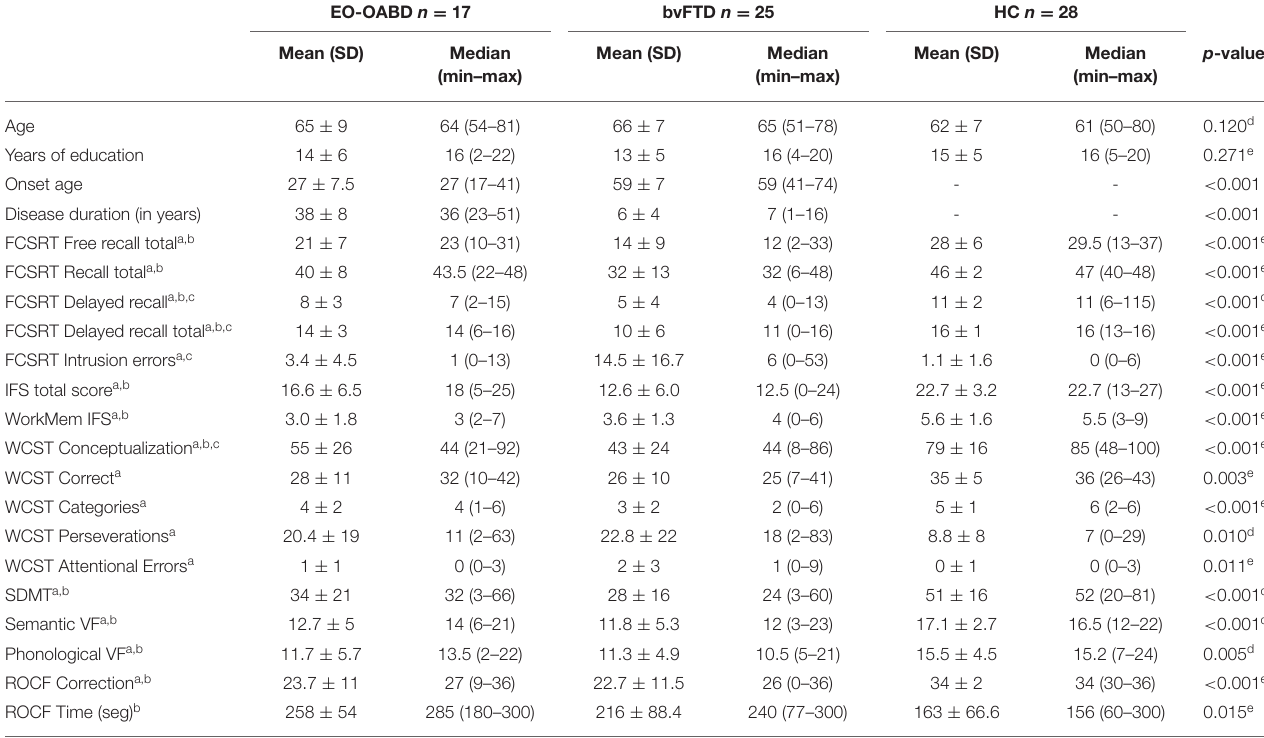
TABLE 1 | Demographic data and neuropsychological